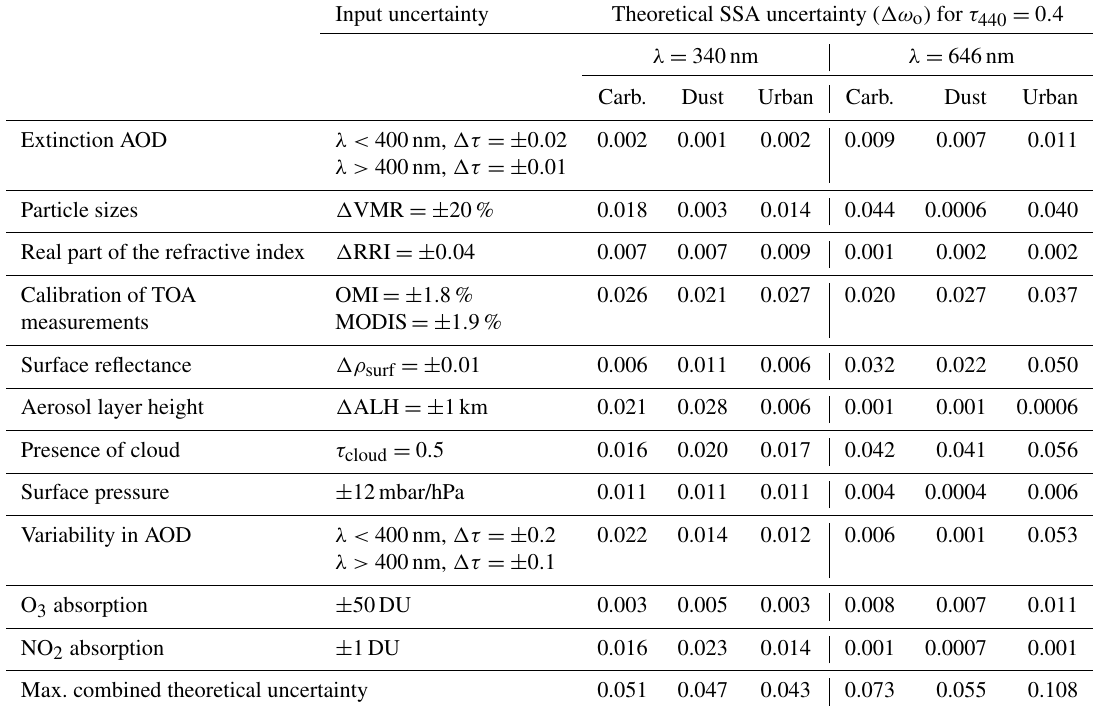
Table 2. Theoretical estimated uncertainties in the retrieval of aerosol SSA due to error in the input variables. The configuration of sensitivity tests is as follows: SZA = 20 ◦ , VZA = 40 ◦ , RAA = 130 ◦ , and ω o ( 388 ) = 0 .